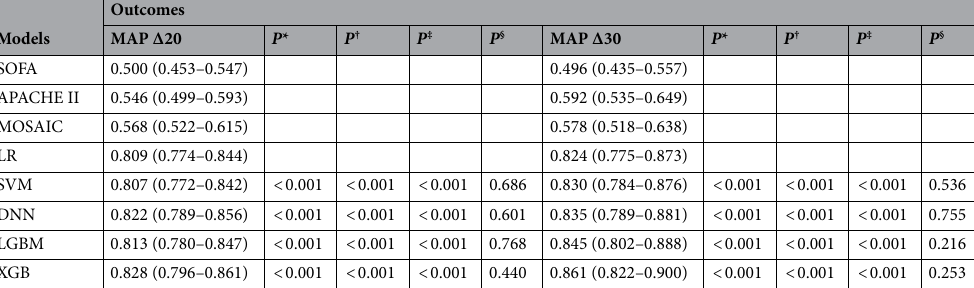
Table 1. Area under the receiver operating characteristic curves of models predicting hypotension within 6 h. *Compared with the APACHE II model. † Compared with the SOFA model. ‡ Compared with the MOSAIC model. § Compared with the LR model. MAP mean arterial pressure, MAP Δ20 reduction in MAP ≥ 20 mmHg from the initial value, MAP Δ30 reduction in MAP ≥ 30 mmHg from the initial value, SOFA Sequential Organ Failure Assessment, APACHE Acute Physiology and Chronic Health Evaluation, MOSAC Mortality Scoring system for AKI with CRRT, LR Logistic regression, SVM support vector machine, DNN deep neural network, LGBM light gradient boosting machine, XGB extreme gradient